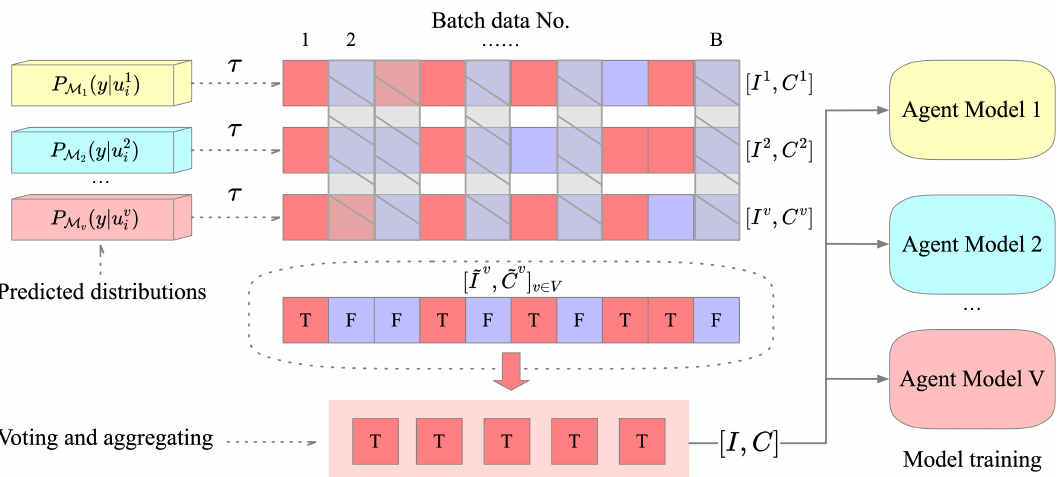
Figure 3. Multi-view agents discriminative information-fusion